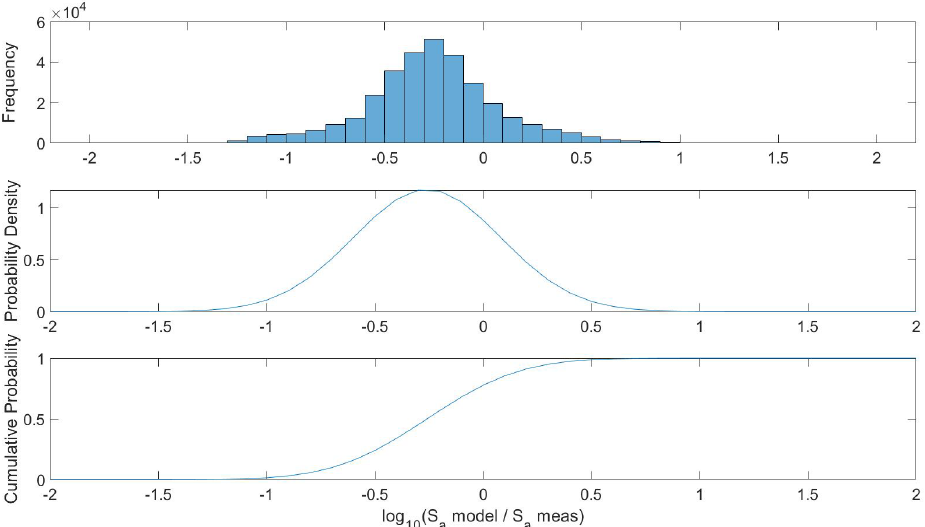
Figure 10. Normalized histogram, probability density function (PDF), and cumulative distribution function (CDF) for the modeled-to- measured aerosol surface area ( S a , mod /S a , meas ). The histogram and PDF serve to indicate the median and spread of the dataset, while the CDF indicates the percentage of data encompassed at a certain data